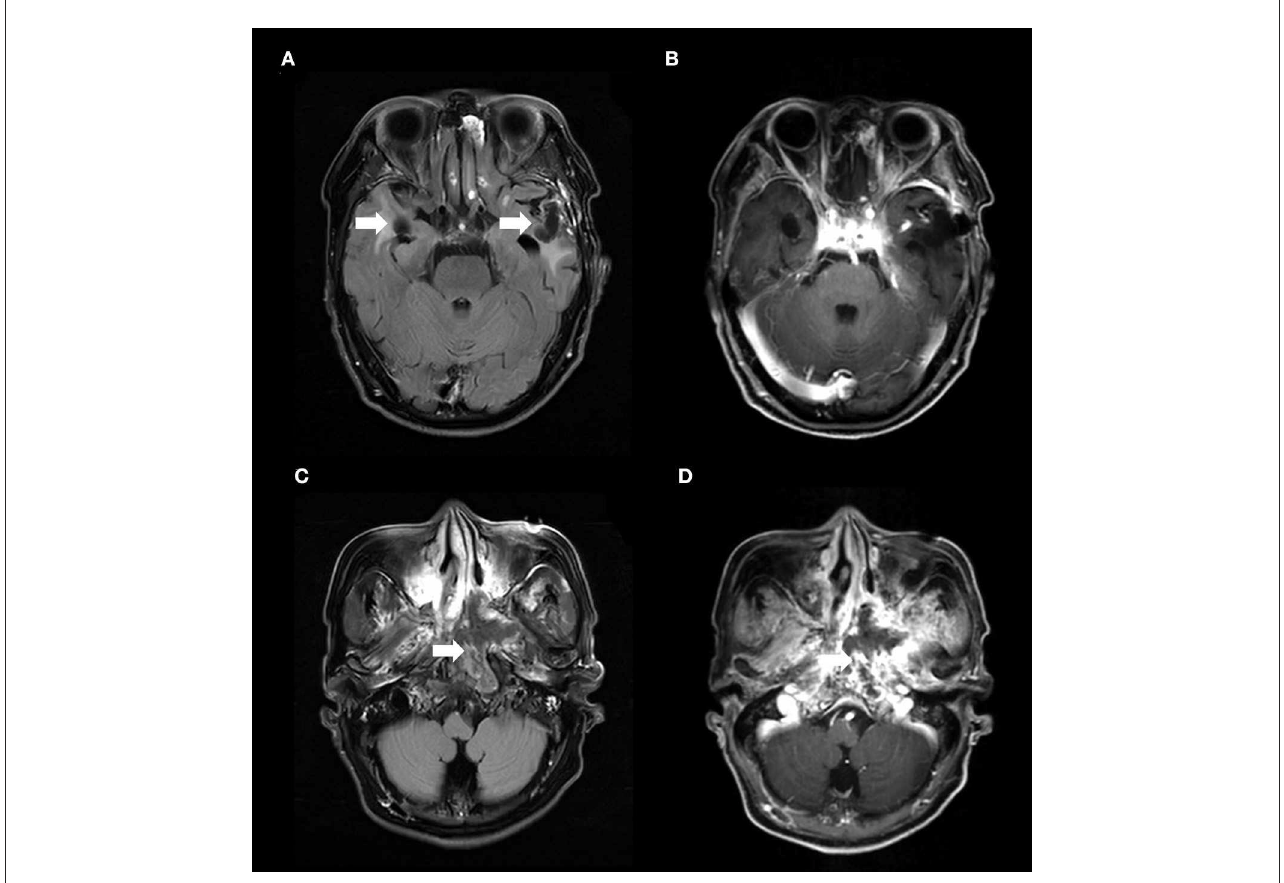
FIGURE1 (A) The axial T2-weighted FLAIR imaging demonstrated irregular hypointense signal changes with patchy edema around them in the bilateral temporal lobes (arrows) and (B) without contrast enhancement in the similar brain structures. The MRI abnormalities on bilateral temporal lobes had been present for approximately 5 months before the patient’s disturbance of consciousness. These abnormalities were presentation of radiation-induced brain necrosis and were not associated with E. miricola encephalitis. (C) Nasopharynx T2-weighted FLAIR imaging showed a heterogeneous signal mass in the left nasopharyngeal lateral wall (arrow). (D) T1-weighted nasopharynx MRI with contrast enhancement showed enhancing lesions in the mass (arrow). FLAIR, fluid-attenuated